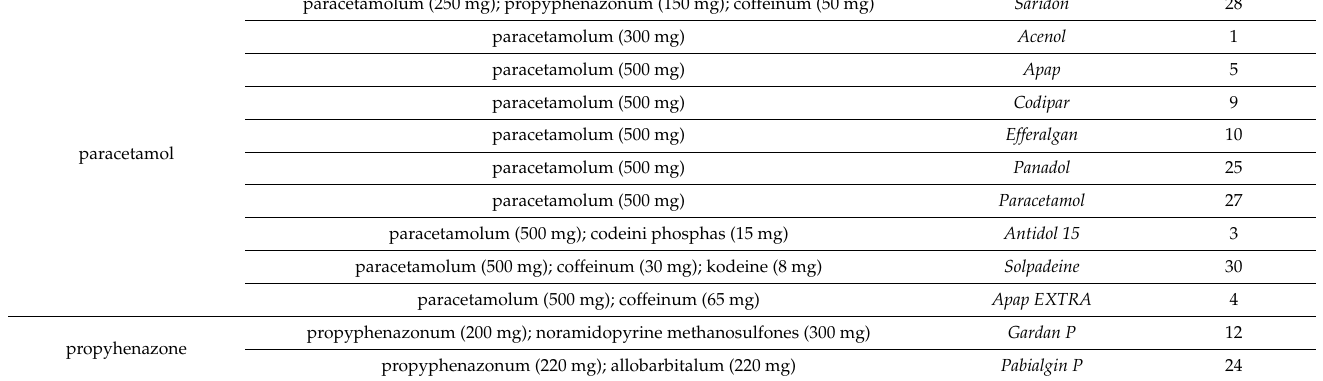
CKD—Questionnaire GP—Questionnaire Question Answer Question Answer Do you use drugs for pain a. yes relief? b. no Which of the listed drugs are you taking? (Please indicate from the most used)